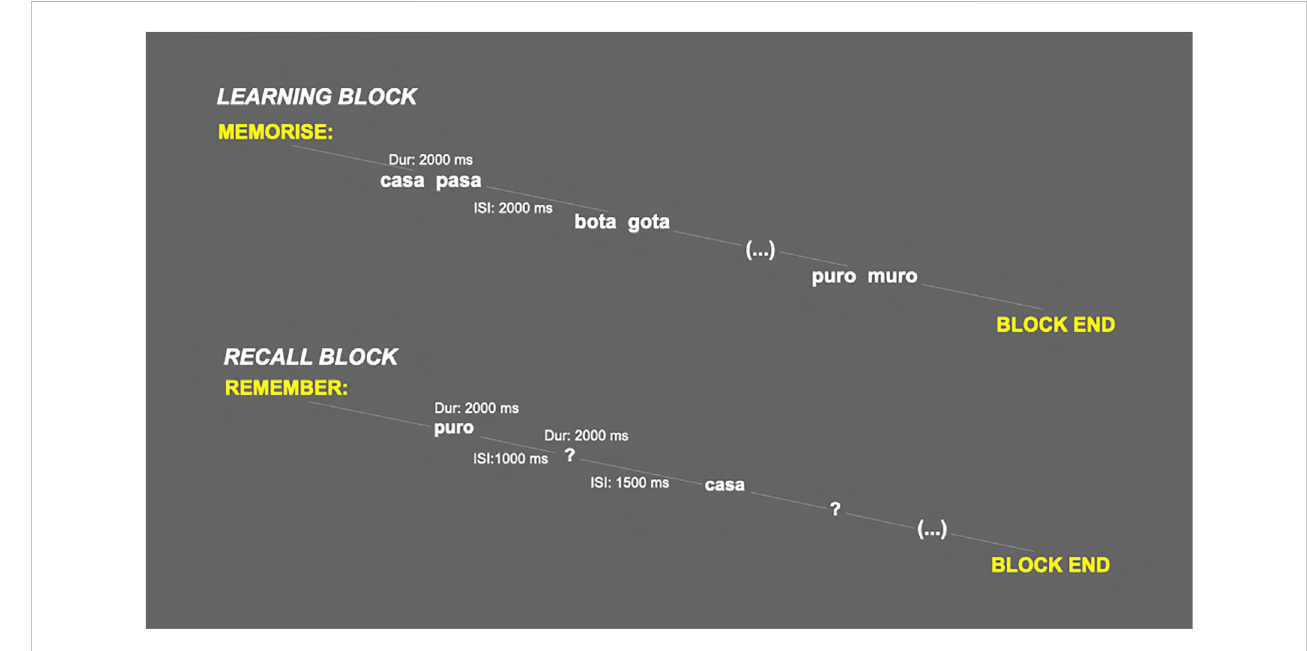
FIGURE 1 Schematic representation of the learning and recall blocks of the verbal paired associates task (Dur: stimulus duration; ISI: interstimulus interval).